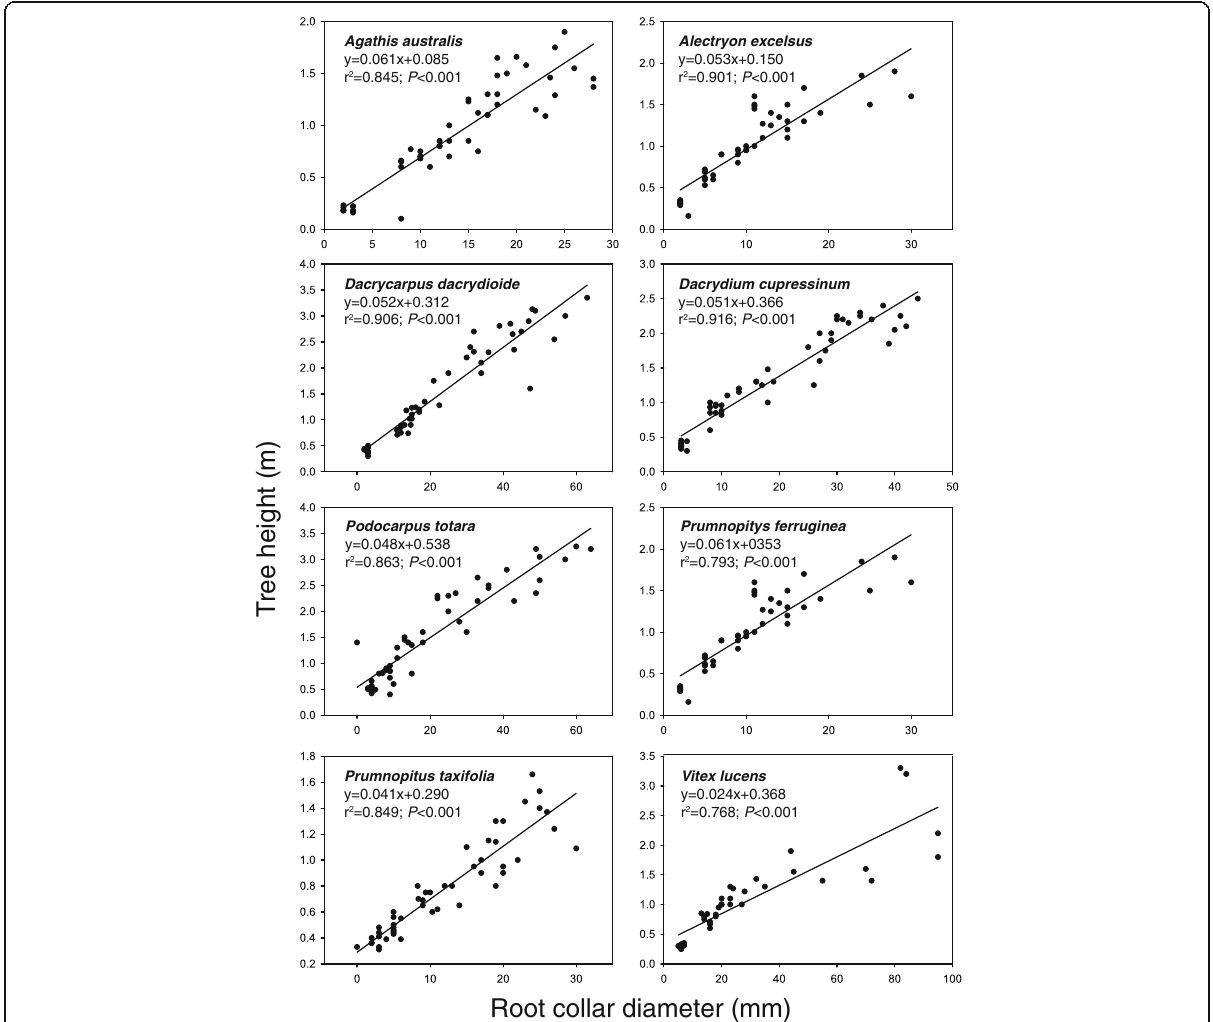
Fig. 3 Linear regression analysis of RCD and tree height. Note that the scale on the y and x axes differs between